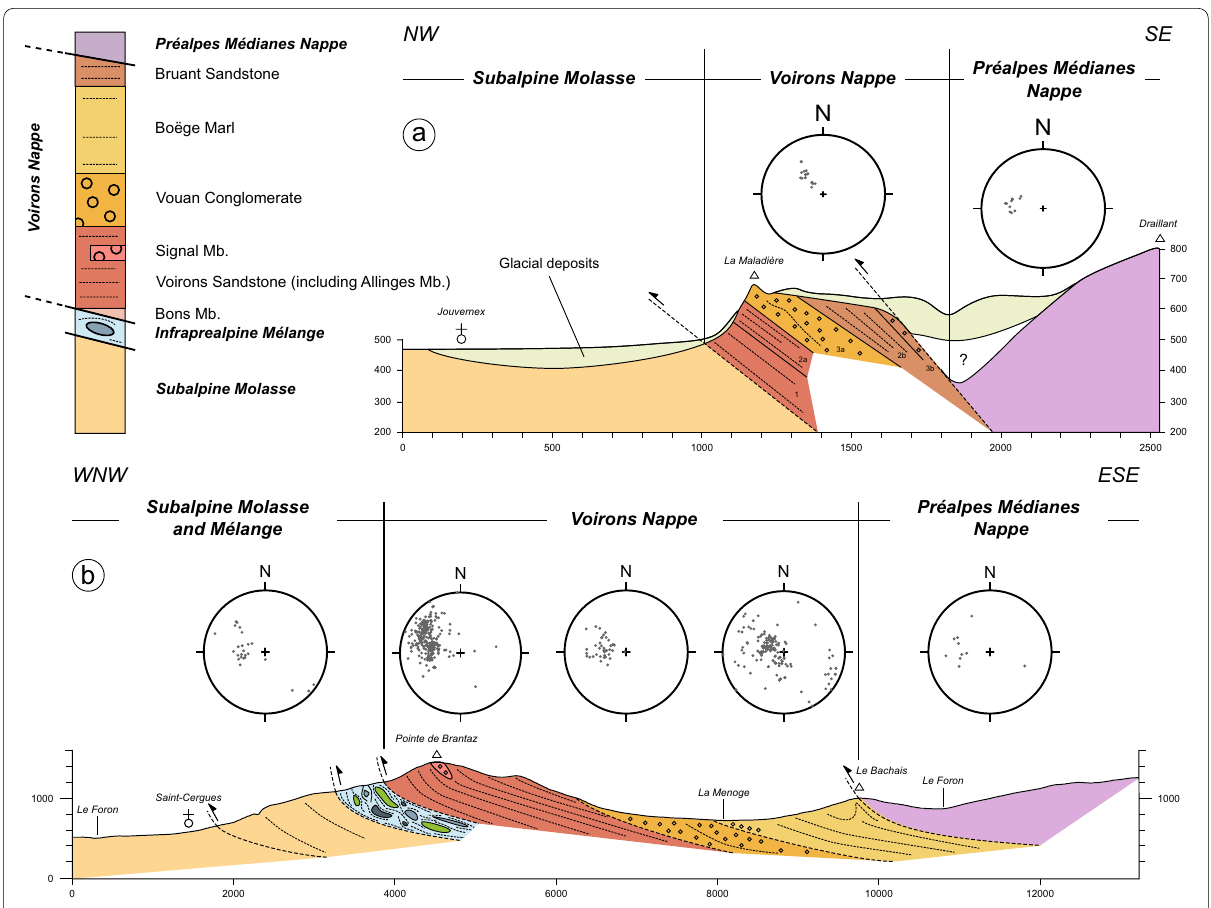
Fig. 3 Geological profiles across the Voirons Nappe with associated pi‑poles of bedding. a Allinges section based on the electric prospect (Büchli et al. 1976, modified). Layer 1 is interpreted as a marly interval. Layer 2 (2a and 2b) is a stack of sandstone beds with interspersed marly interbeds, whereas Layer 3 (3a and 3b) is considered as an alternation of sandy and conglomeratic beds. Stratigraphic attribution of covered units is tentative. Layer 3a is the only exposed unit at the Maladière and corresponds to the Vouan Conglomerate (Grotte aux Loups exposure). b Voirons section. Quaternary deposits are not represented due to their very low thickness. Please refer to Fig. 2 for location. Bedding measurements data from the Préalpes Médianes Nappe are reported from Lower Jurassic layers (La Vudalla Fm. and Chauderon Fm.) since Triassic beds are both poorly exposed and crudely stratified. Please note that both Foron rivers are not the same, the name Foron is frequently ascribed to small rivers in this